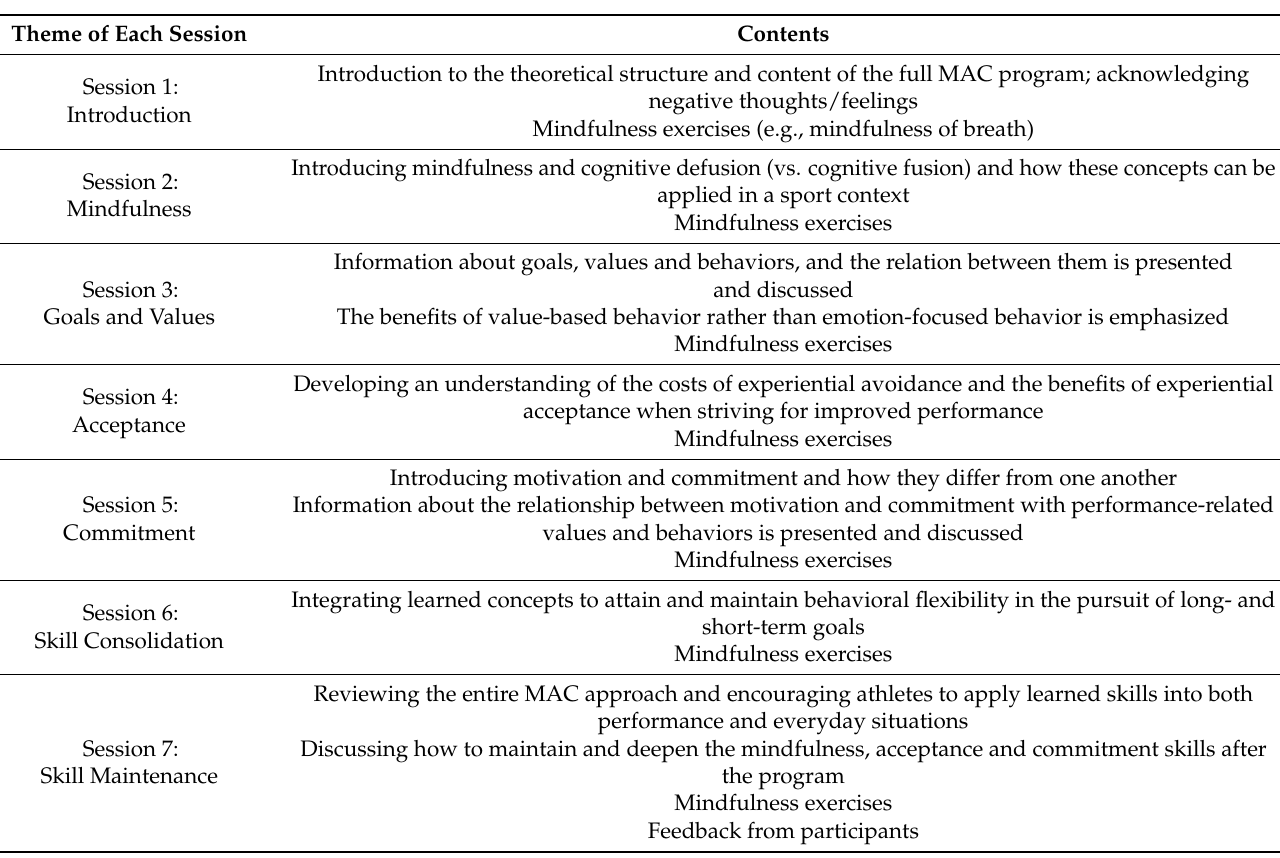
Table 1. Mindfulness–Acceptance–Commitment Training (MAC) Session Content